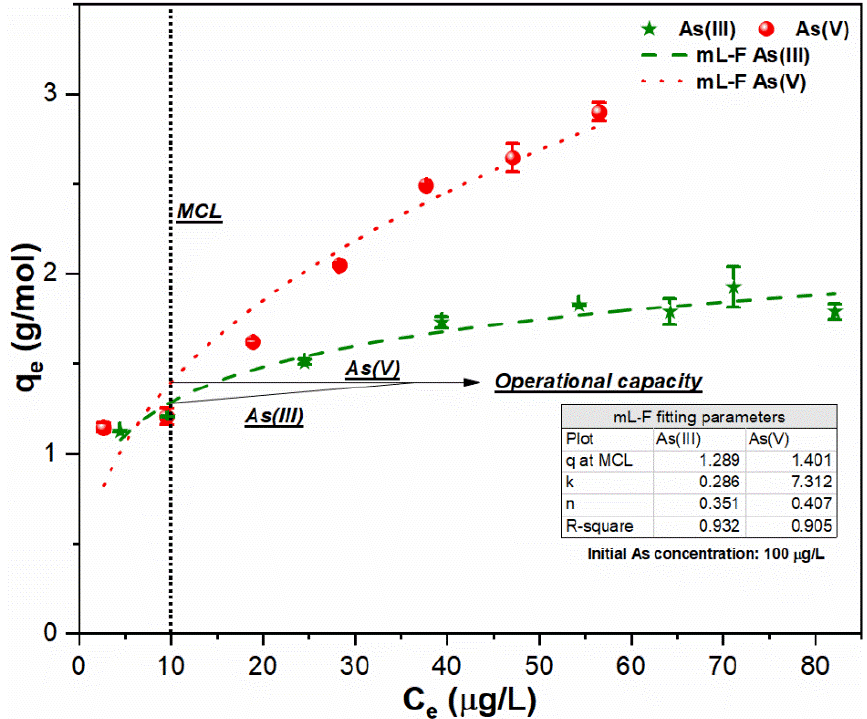
Figure 3. Sorption of As (III, V) species using mL-F model onto FHO surface at conditions: optimum pH of 7; temperature of 25 °C; FC dosage of As (III): 0.01–0.085 mM; As (V): 0.015–0.085 mM; and initial As loading of 100 µg/L.